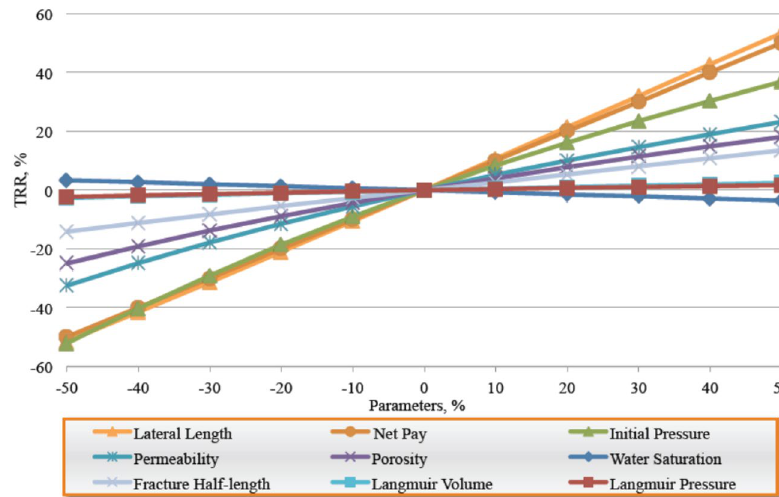
parametrical effects on reserve assessment (Adapted from Dong et al.